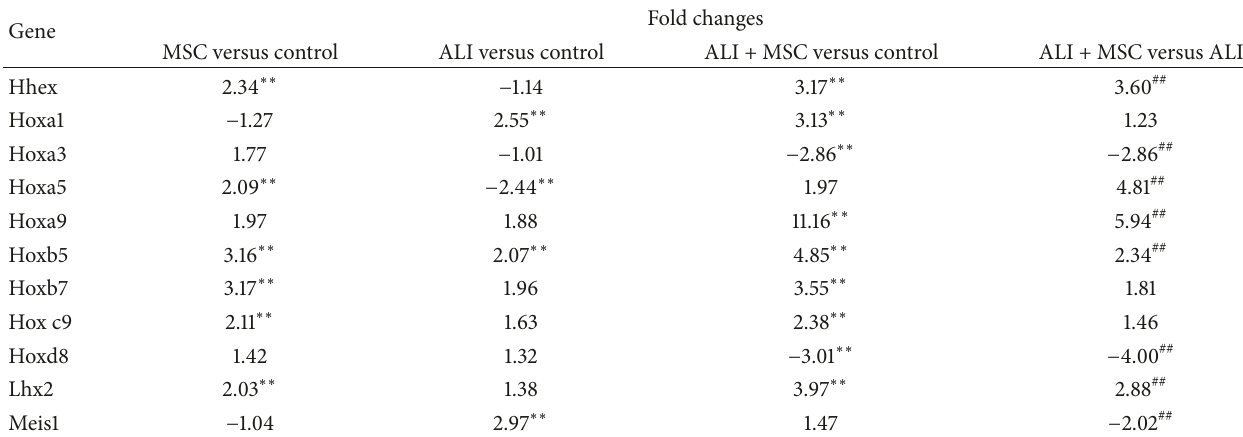
Table 1: HOX gene expression levels in lungs after MSCs